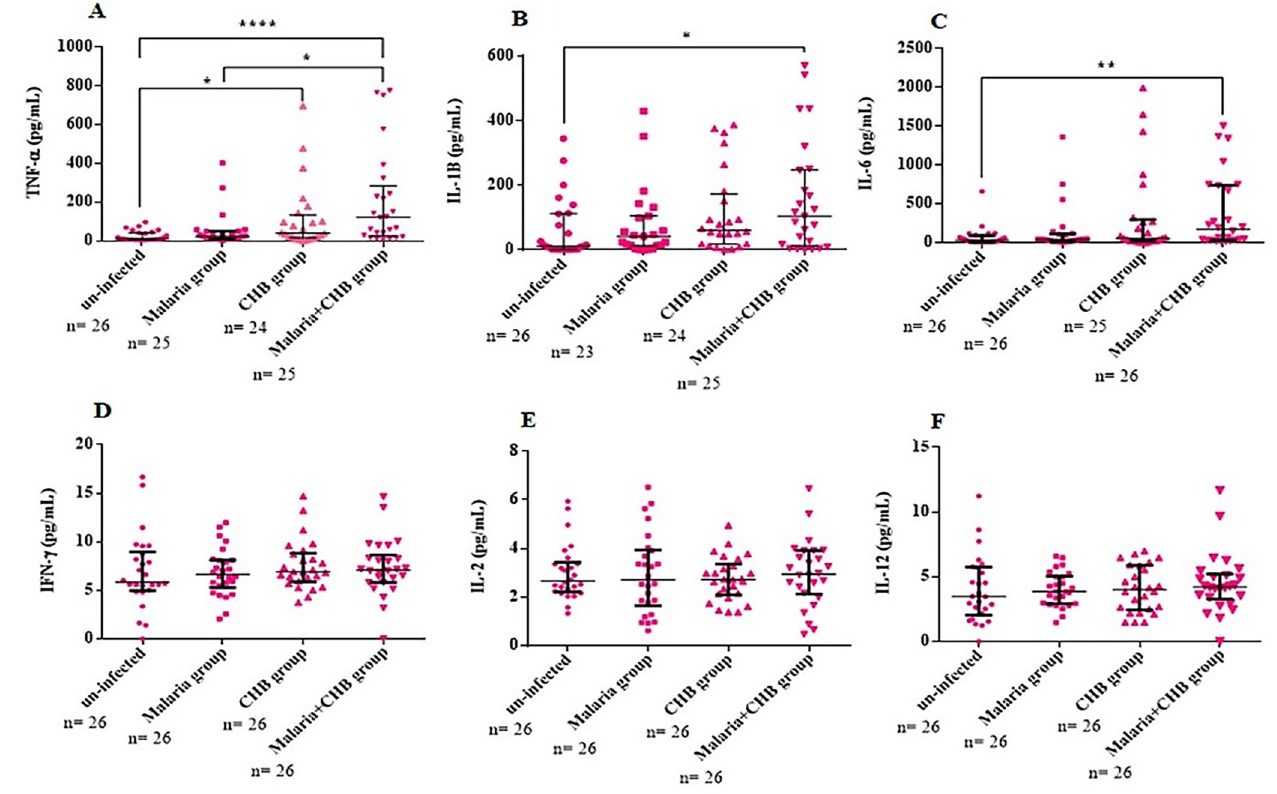
Fig 3. Differences in levels of pro-inflammatory cytokines amongst the groups of pregnant women. Dunn’s multiple comparison tests for differences in serum levels of (A) tumour necrosis factor alpha (TNF- α ), (B) interleukin (IL)-1 β , (C) IL-6, (D) interferon gamma (IFN- γ ), (E) IL-2 and (F) IL-12. Statistical significance was observed at � P < 0.05, �� P < 0.01 and ���� P < 0.0001. Horizontal bar with error bars represents the median and the interquartile range respectively. n = number of samples of each category of the study participants